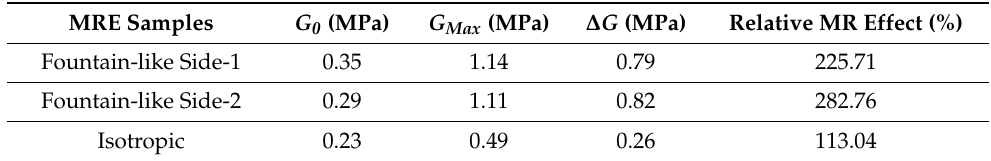
Table 5. The zero-field storage modulus ( G 0 ), the magnetically induced modulus ( ∆ G ), and the relative MR effect of the MRE samples.